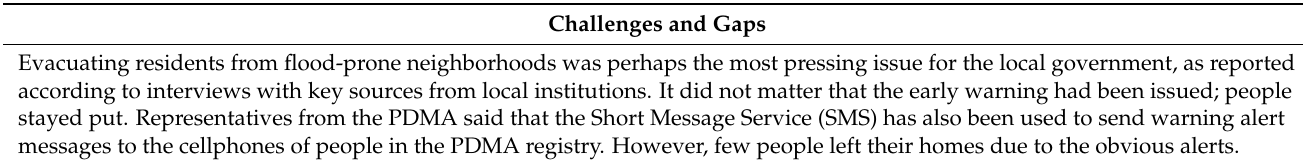
Table 4. Institutional challenges and gaps for integrating gender aspects into early warning